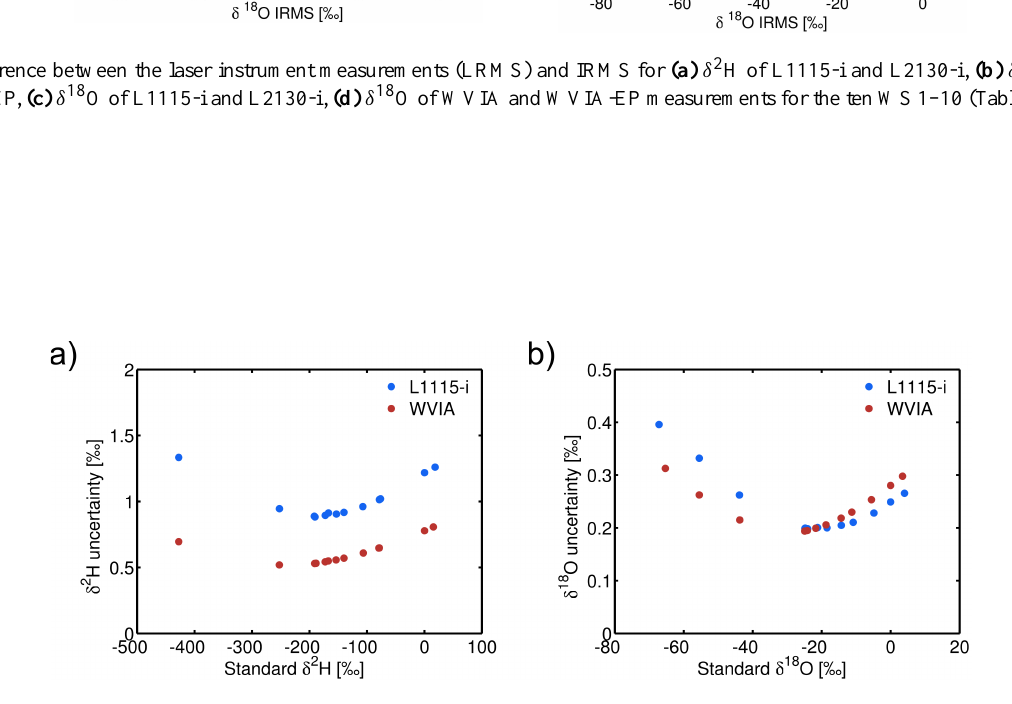
Fig. 3. Uncertainty of (a) δ 2 H and (b) δ 18 O isotope calibration runs by L1115-i and WVIA as a function of isotopic composition of the WS 1–10 as well as the IAEA standards (Table